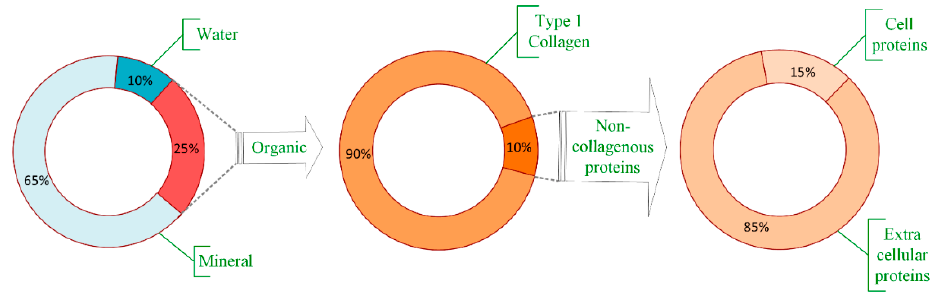
Figure 1. Bone composition. Realized based on [10]. Bone tissue can assume a compact (cortical bone) or trabecular (cancellous